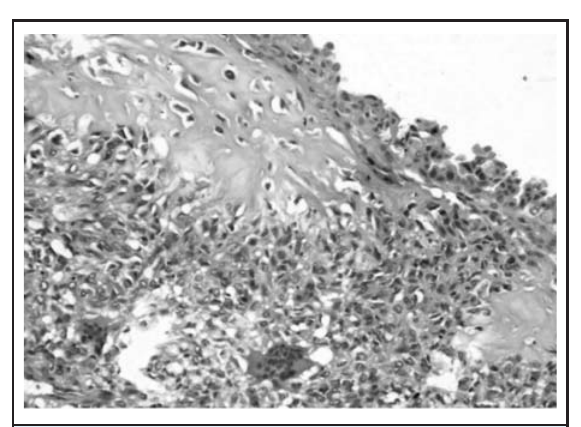
Figure 2. Tumor cells with osteoid production. Mul- tinucleated giant cells are seen at the bottom. (HE stain x100)